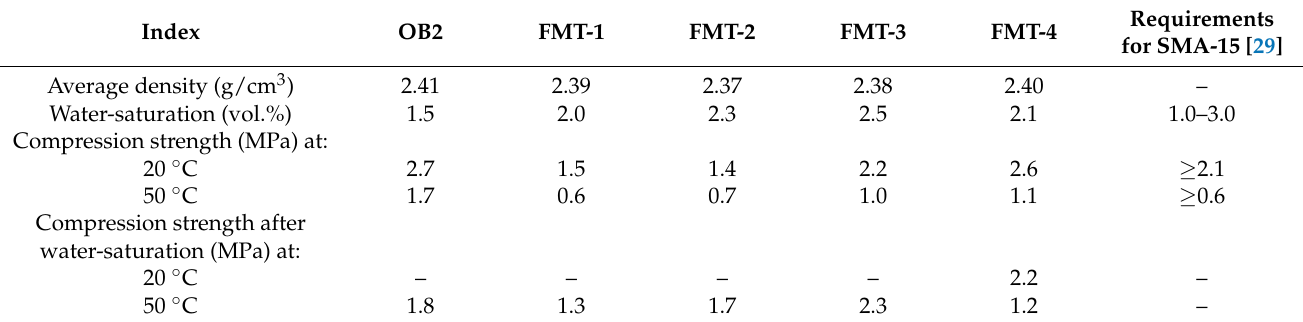
Table 6. Physical and mechanical properties of